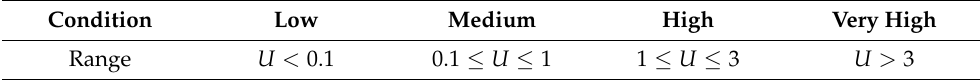
Figure 4. Fuzzy rules for fault identification by using the IEC ratio method. Table 8. The input range of triangular membership function for the ICE ratio method.